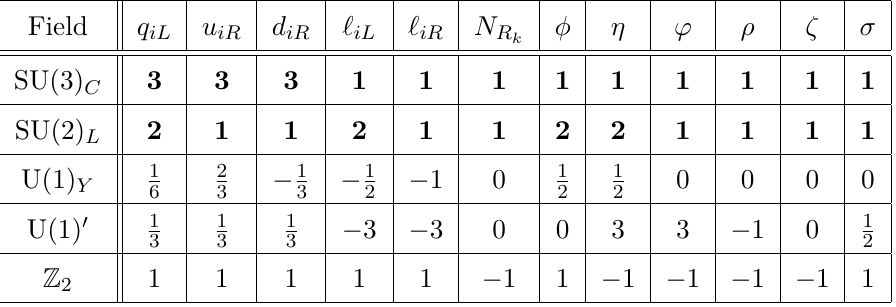
Table 1 . Particle charge assignments under the SU(3) C ⊗ SU(2) L ⊗ U(1) Y ⊗ U(1) 0 ⊗ Z 2 symmetry. Here i = 1 , 2, 3 and k = 1 ,